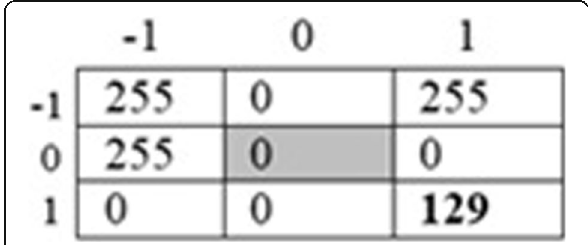
Fig. 4 Illustration of case 2 in case A Fig. 5 Example of corrupted image segment for case 3 of case